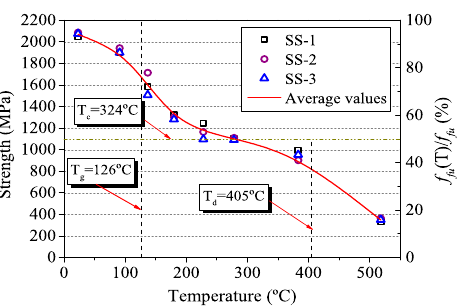
Figure 6. Tensile strength degradation in steady state tests.